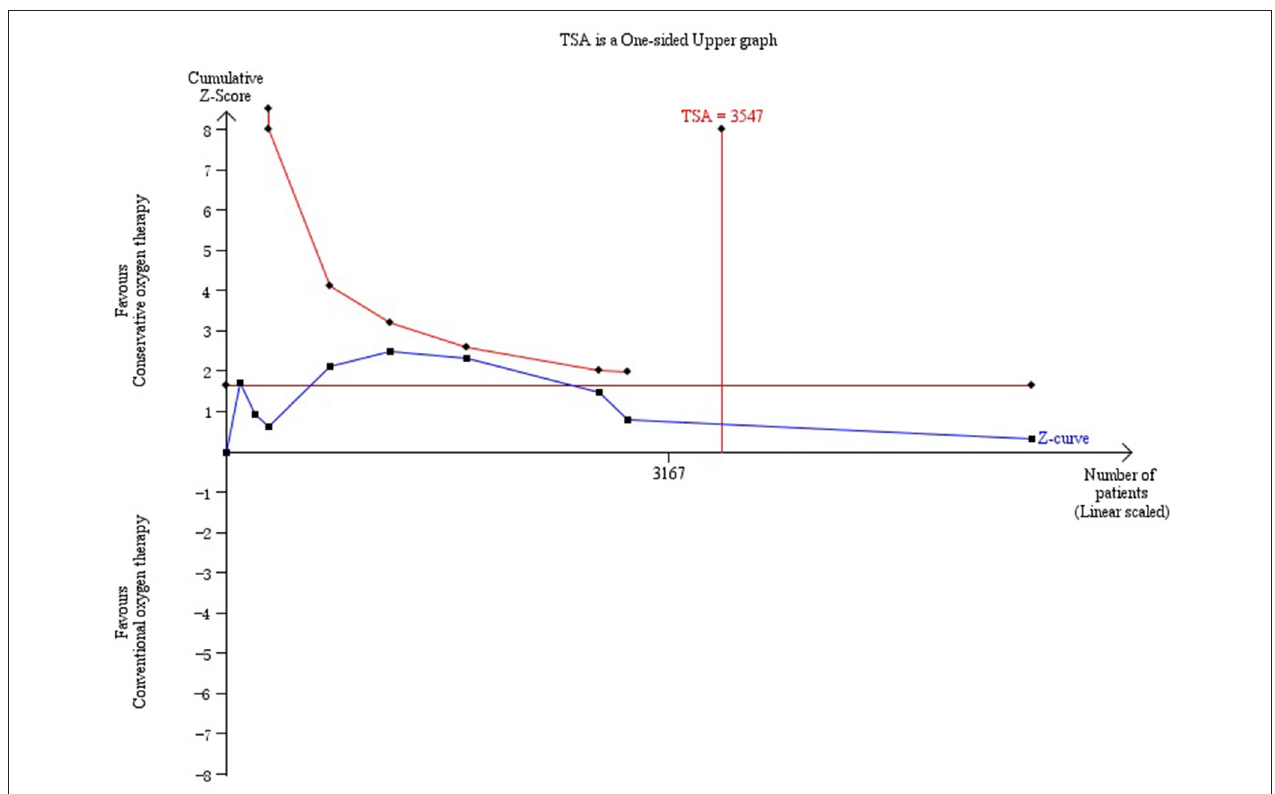
FIGURE 2 | Trial sequential analysis of mortality. TSA, trial sequential analysis.